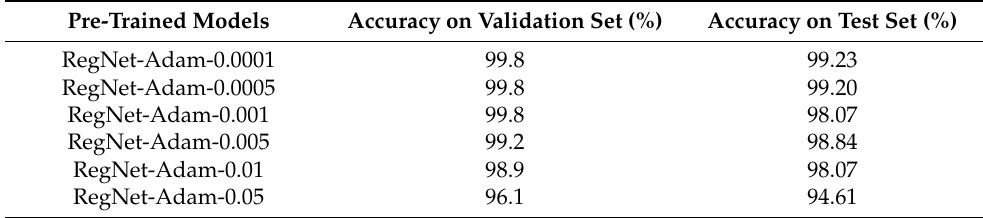
Table 3. The average accuracy of the model with different learning rates.